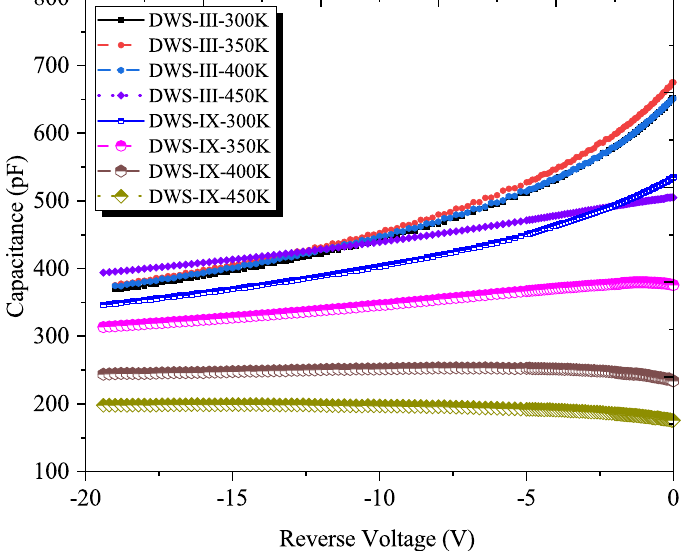
Figure 6. Temperature dependence of reverse C-V characteristics for p -type 4H-SiC- DWS# III and DWS# IX